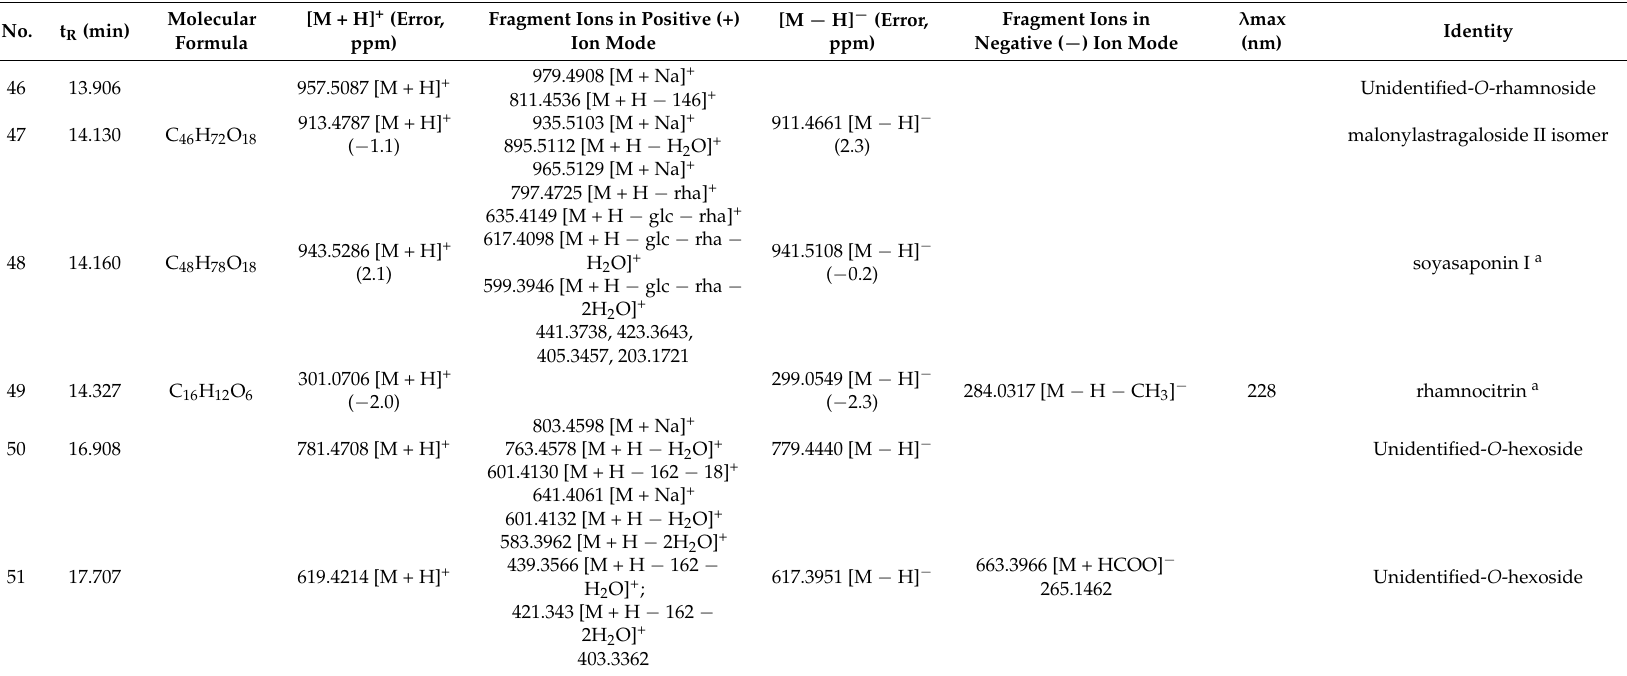
Table 4. Compounds identified in ME of AMF by UPLC-Q-TOF MS